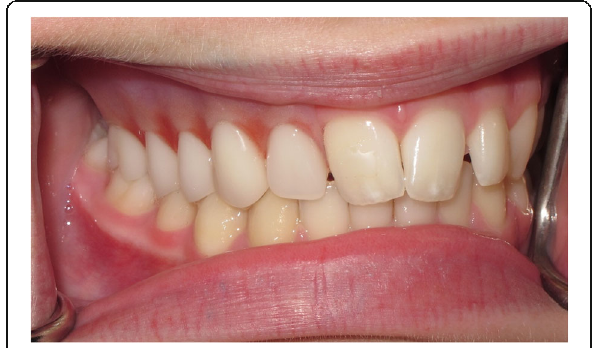
Fig. 8 Anterior view of definitive obturator prosthesis in occlusion